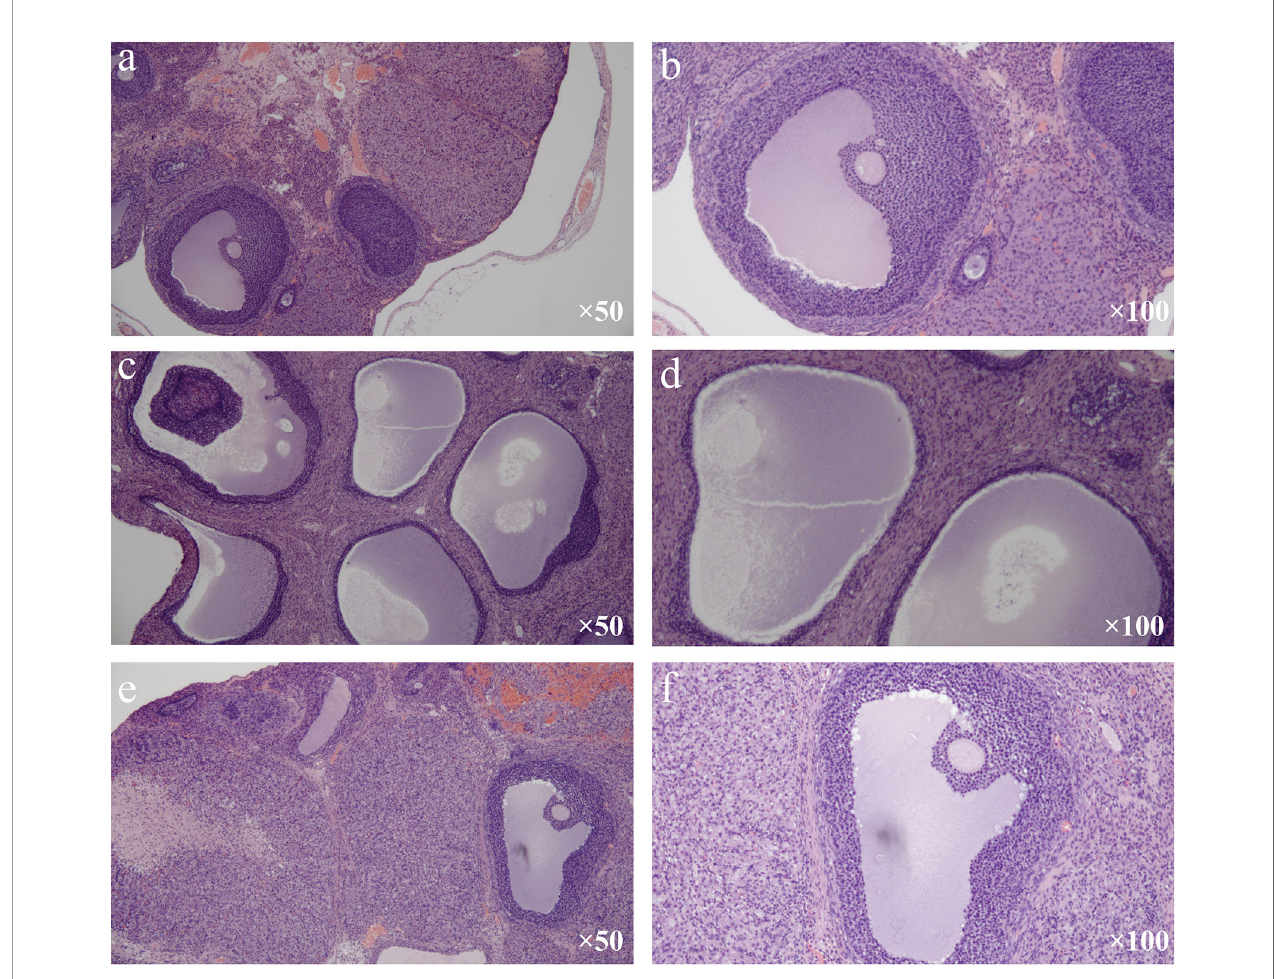
FIGURE 2 | Changes in ovarian histomorphological (H&E stain). (A, B) Control group. (C, D) Model group. (E, F) Treatment